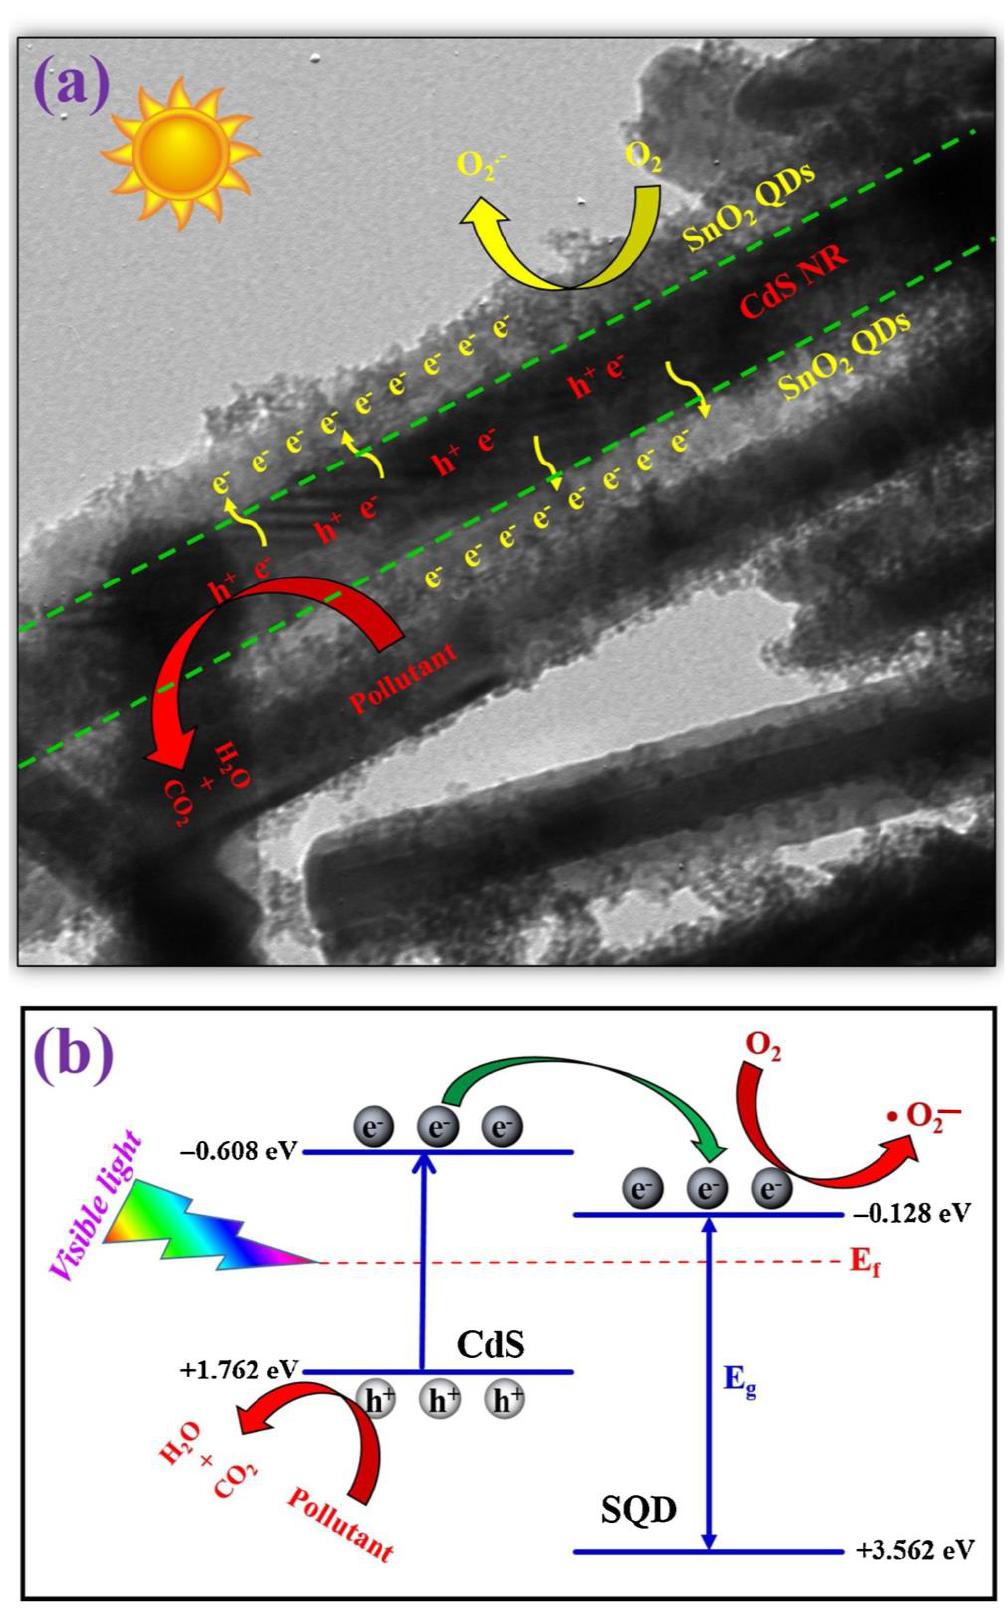
Figure 5. ( a ) CdS@SnO 2 core-shell NRs ’ photocatalytic degradation and ( b ) charge-transfer mecha- nism [40], Copyright 2019, Elsevier.